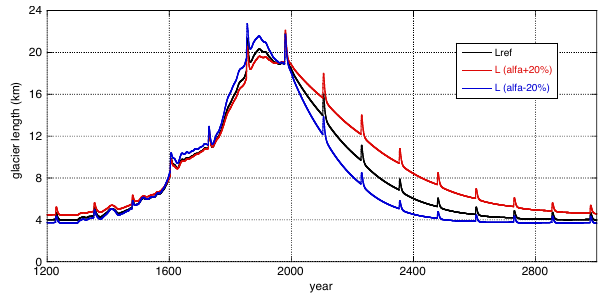
Figure 11. The effect of different values of α m on the simulated Fig. 11. The effect of different values of α m on the simulated glacier length. The ‘reference’ 2 glacier length. The “reference” simulation is shown in simulation is shown in read. 3